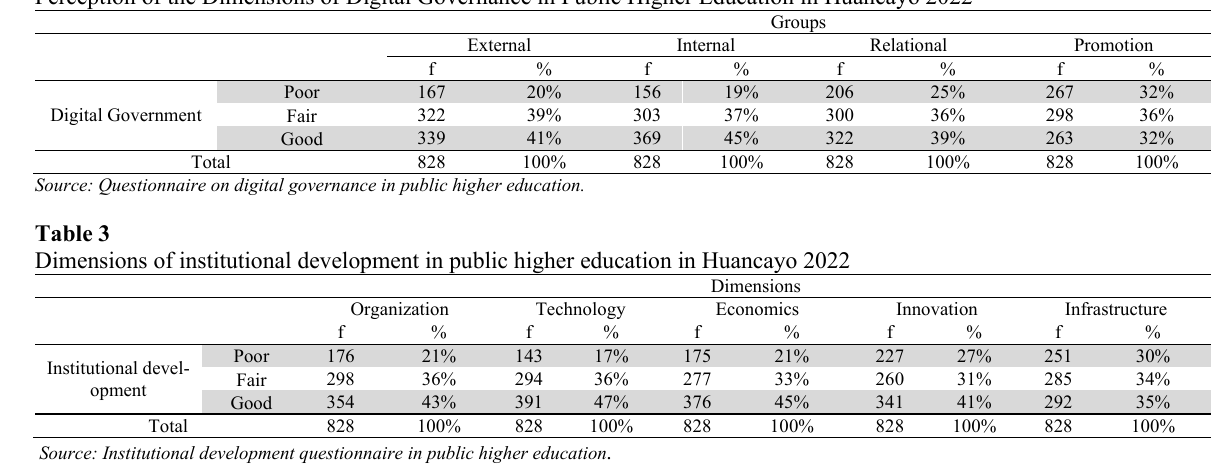
Perception of the Dimensions of Digital Governance in Public Higher Education in Huancayo 2022